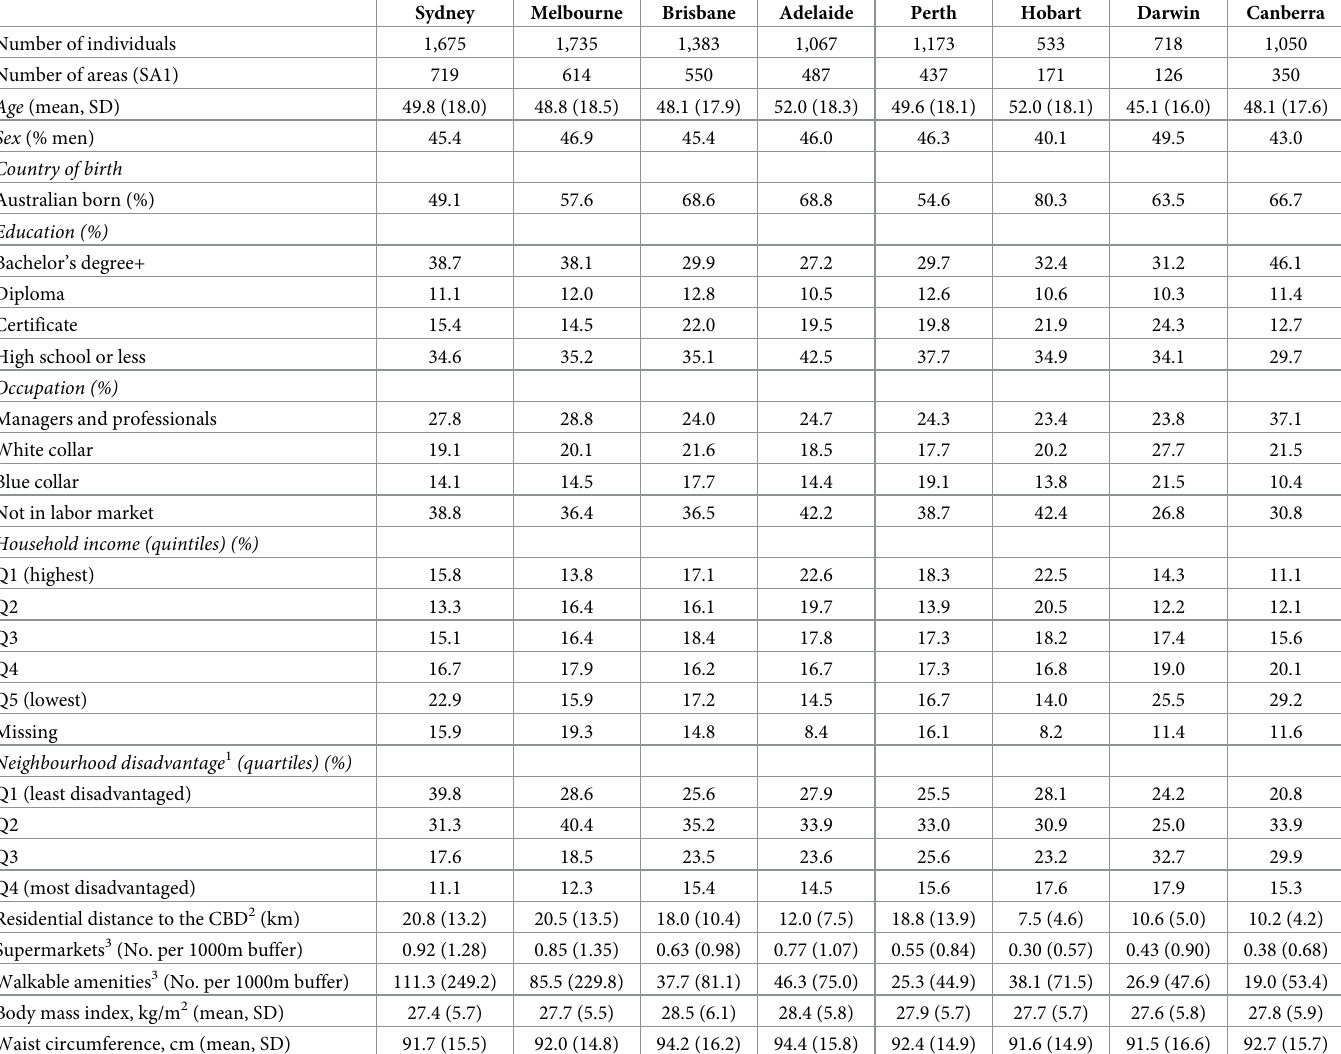
Table 1. Sociodemographic, built environment, and body size characteristics of the analytic sample by capital